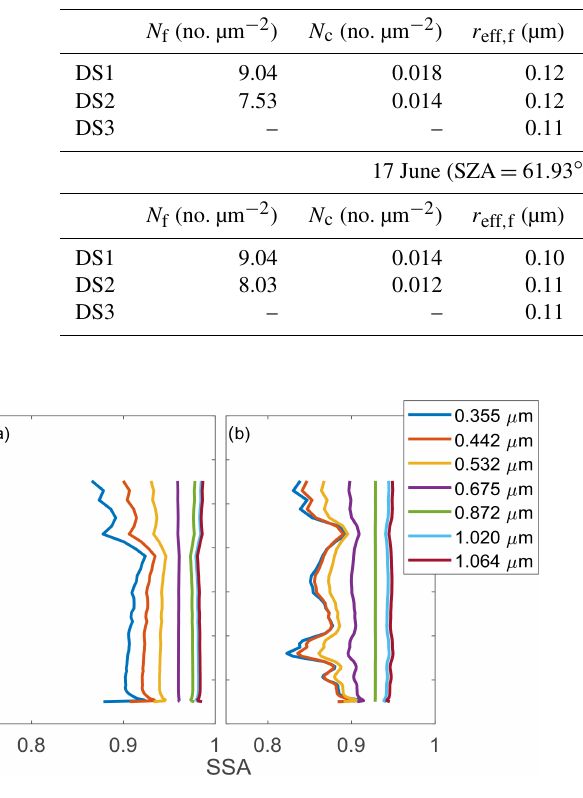
Figure 3. SSA profiles obtained from GRASP/DS1 on 16 June (a) and 17 June (b)